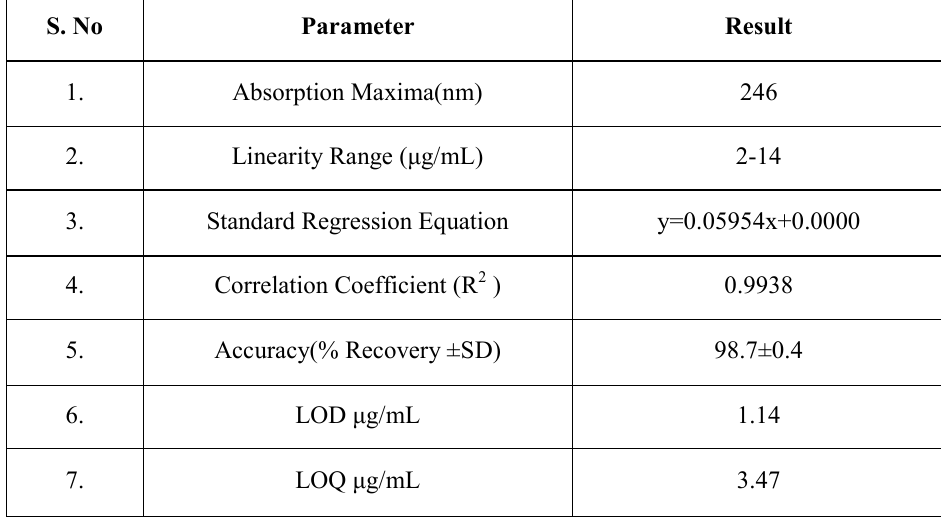
Table 2. Validation